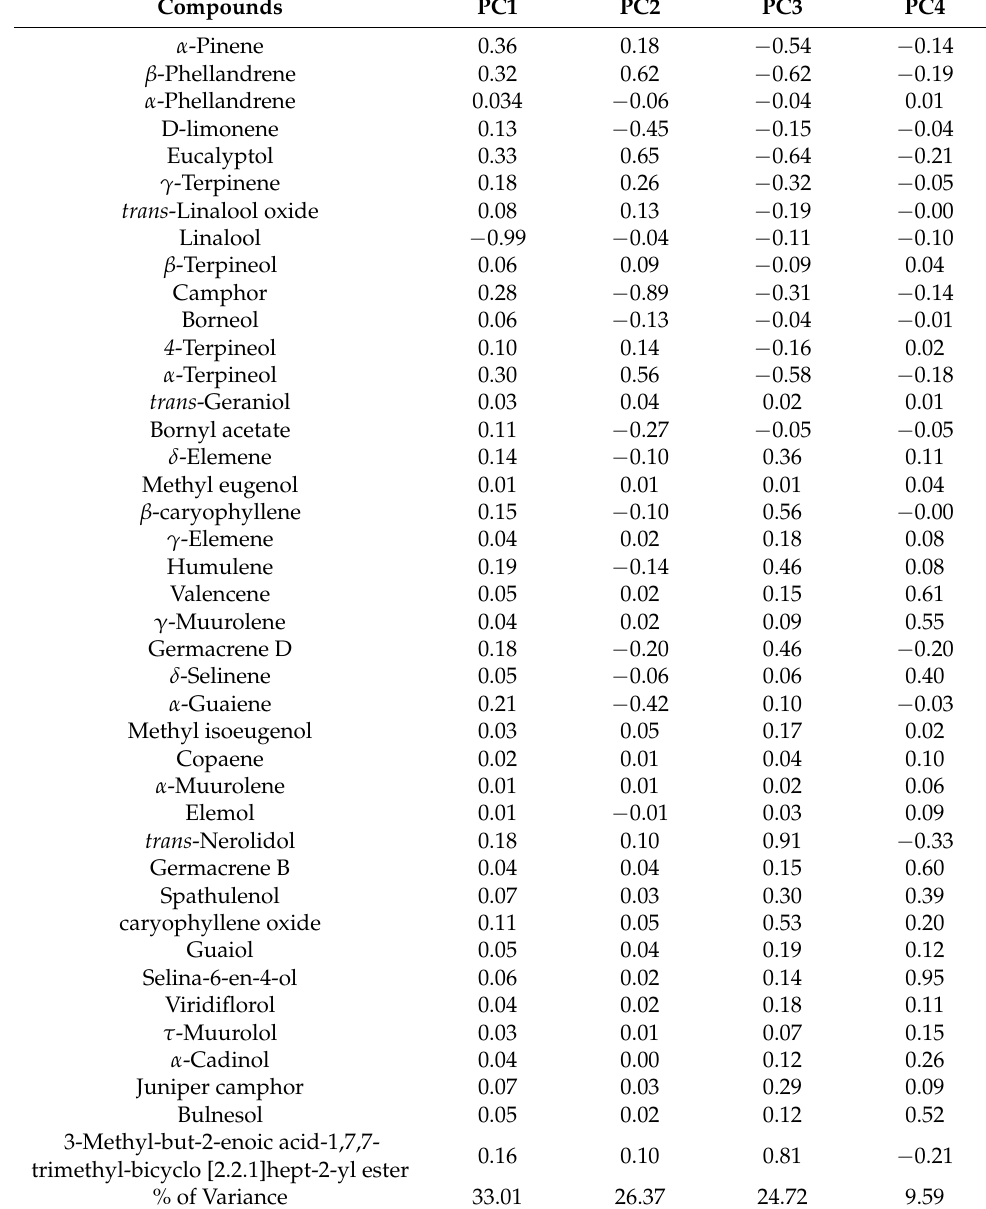
Table 5. Four principal components of the 41 essential oil compounds of C. camphora .